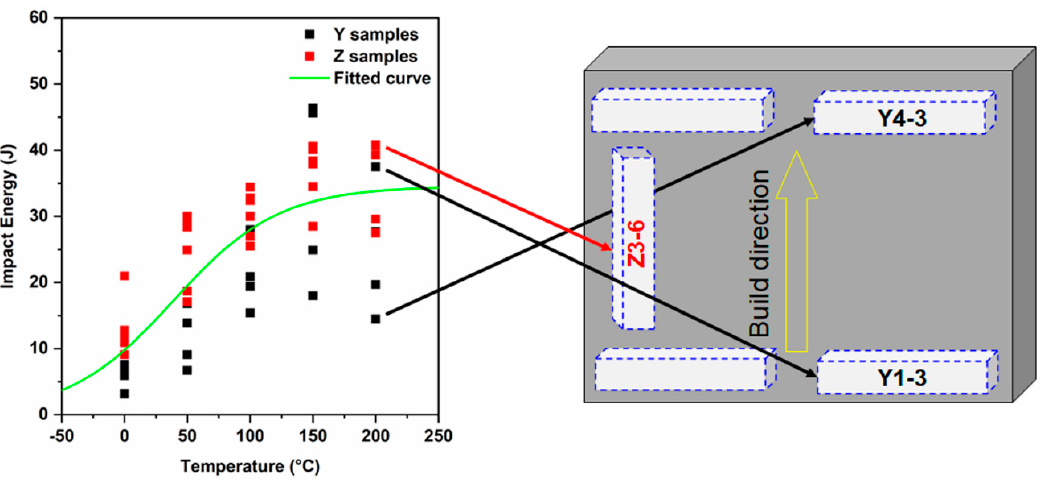
Figure 3. Charpy impact toughness results of perpendicular ( Y ) and parallel ( Z ) to build direction.